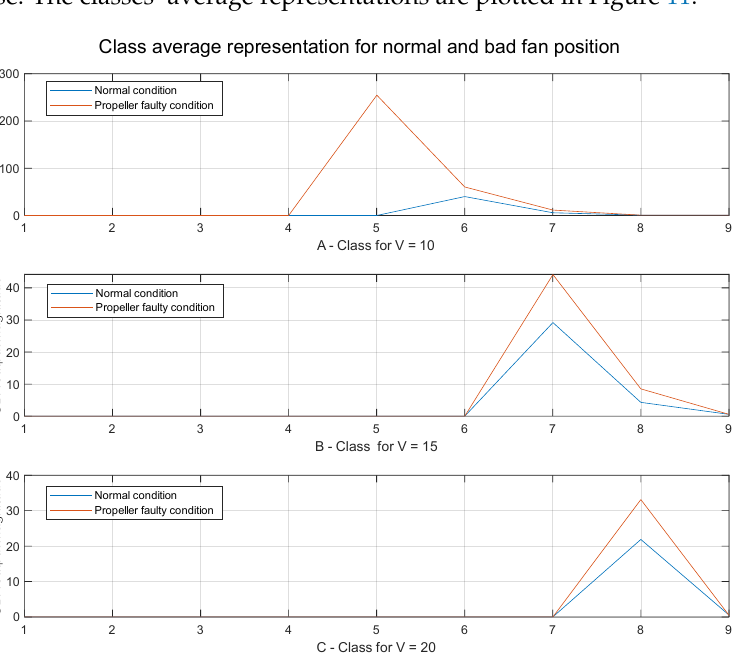
Figure 11. Normalized class average representation for V = 10 (A), V = 15 (B) and V = 20 (C).